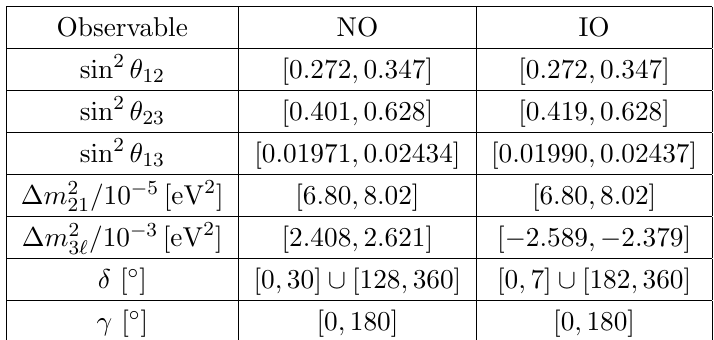
Table 2 . The 3 (cid:27) ranges for the lepton mixing parameters and mass-squared di(cid:11)erences from NuFIT 3.1 (November 2017) [76, 77]. Here (cid:1) m 2